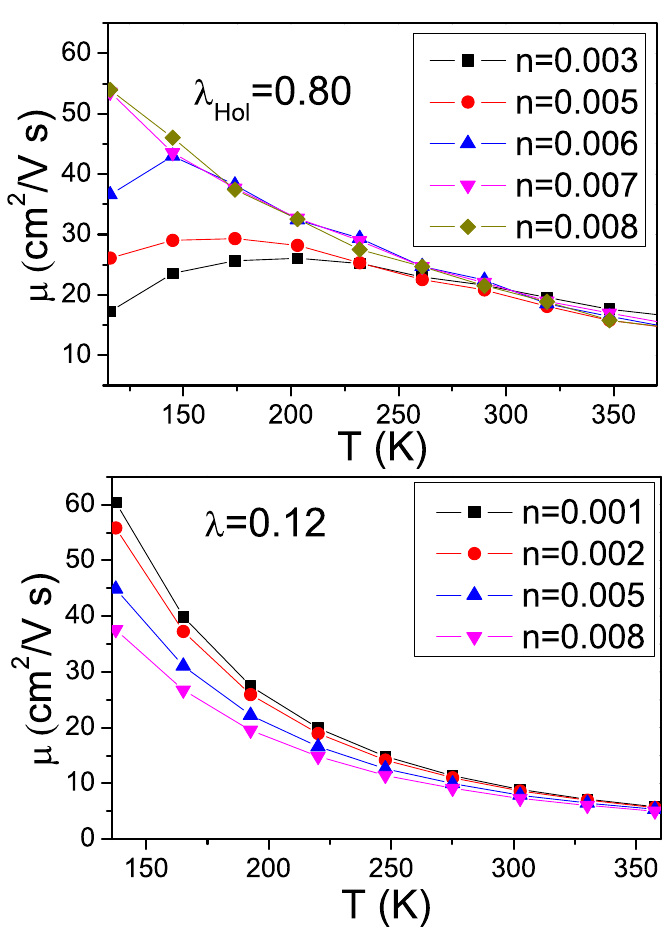
( Top ) Mobility along the z direction within the anisotropic Holstein model as a function of temperature T for different particle densities at λ Mobility along the a direction within the rubrene model as a function of temperature T for different particle densities at λ = 0 . 12 . We assume the hopping parameter t t = 118 . 6 a